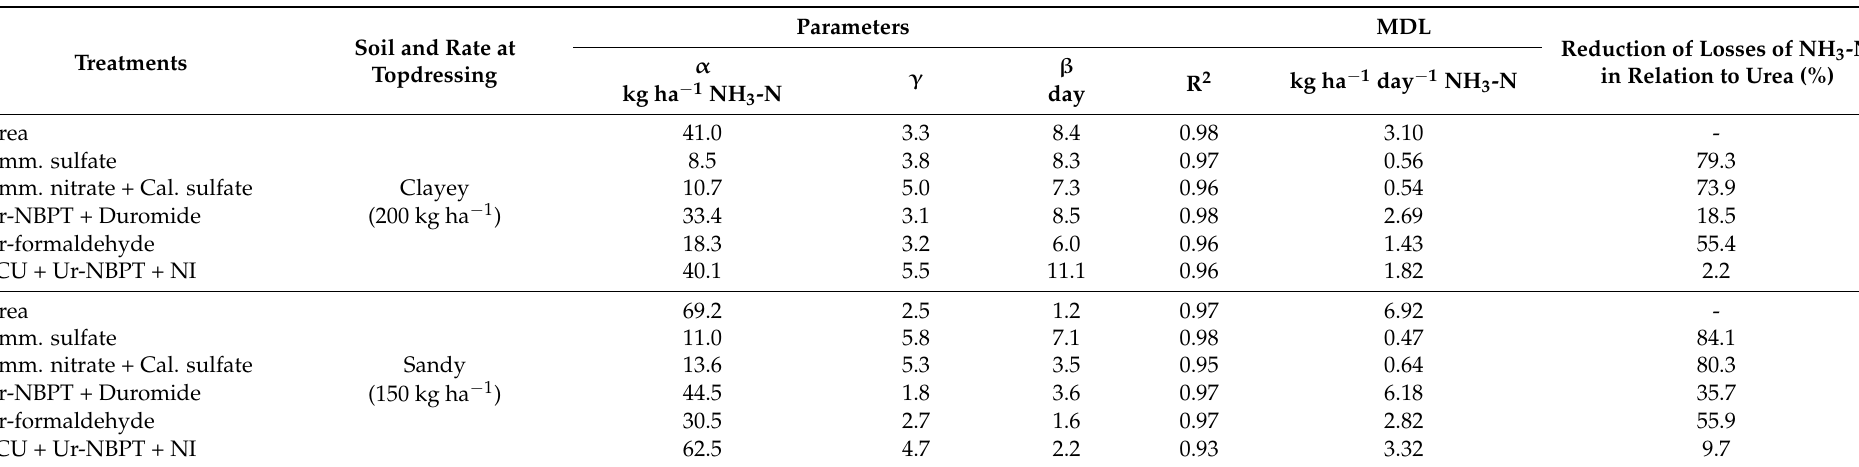
Table 2. Nonlinear regression parameters adjusted (logistic model) for NH 3 -N volatilization cumulative losses for conventional and enhanced efficiency